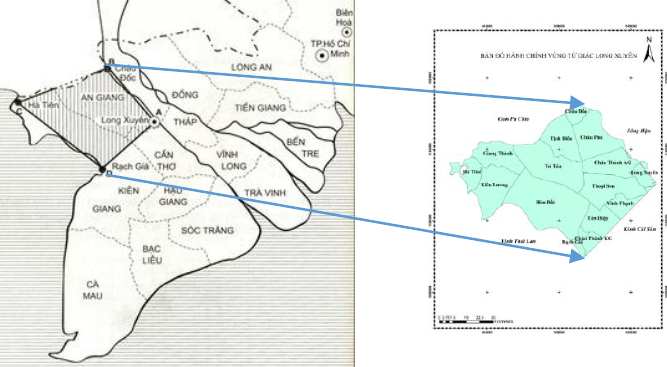
Figure 1: Long Xuyen Quadrangle’s administrative